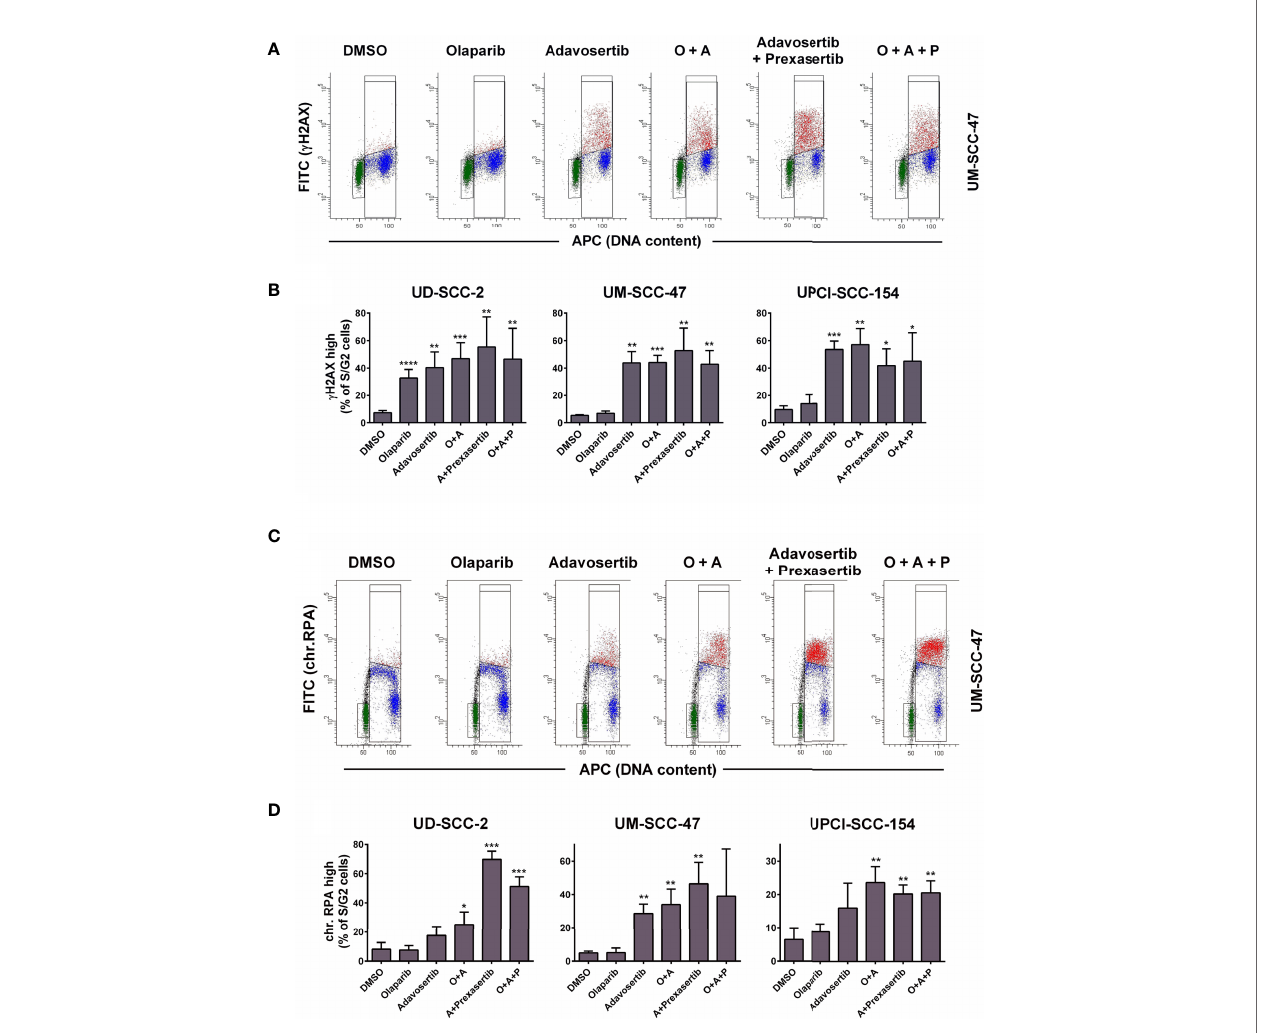
FIGURE 3 | Effect of PARP and intra-S/G2 checkpoint inhibition on g H2AX and chromatin-bound RPA staining intensity. Cells were treated with inhibitors as indicated for 24 h before fi xation, staining, and fl ow cytometric measurements. In case of RPA staining the cells were pre-extracted before fi xation. (A) Examples of the fl ow cytometric measurement of g H2AX. Gates are set to select cells in G1 (green), in S/G2 (red & blue) or cells in S/G2 with enhanced g H2AX levels (red). (B) Fraction of S/G2 phase cells that demonstrate enhanced g H2AX levels. (C) Examples of the fl ow cytometric measurement of chromatin-bound RPA, which is highest in the replicative S-phase. Gates are set to select cells in G1 (green), in S/G2 (red and blue) or cells in S with enhanced RPA levels (red). (D) Fraction of S/G2 phase cells that demonstrate enhanced RPA staining levels. Asterisks depict signi fi cant differences to solvent (DMSO) treatment with *, **, *** and **** indicating p < 0.05, p < 0.01, p < 0.001, and p < 0.0001, respectively (two-tailed Student ’ s